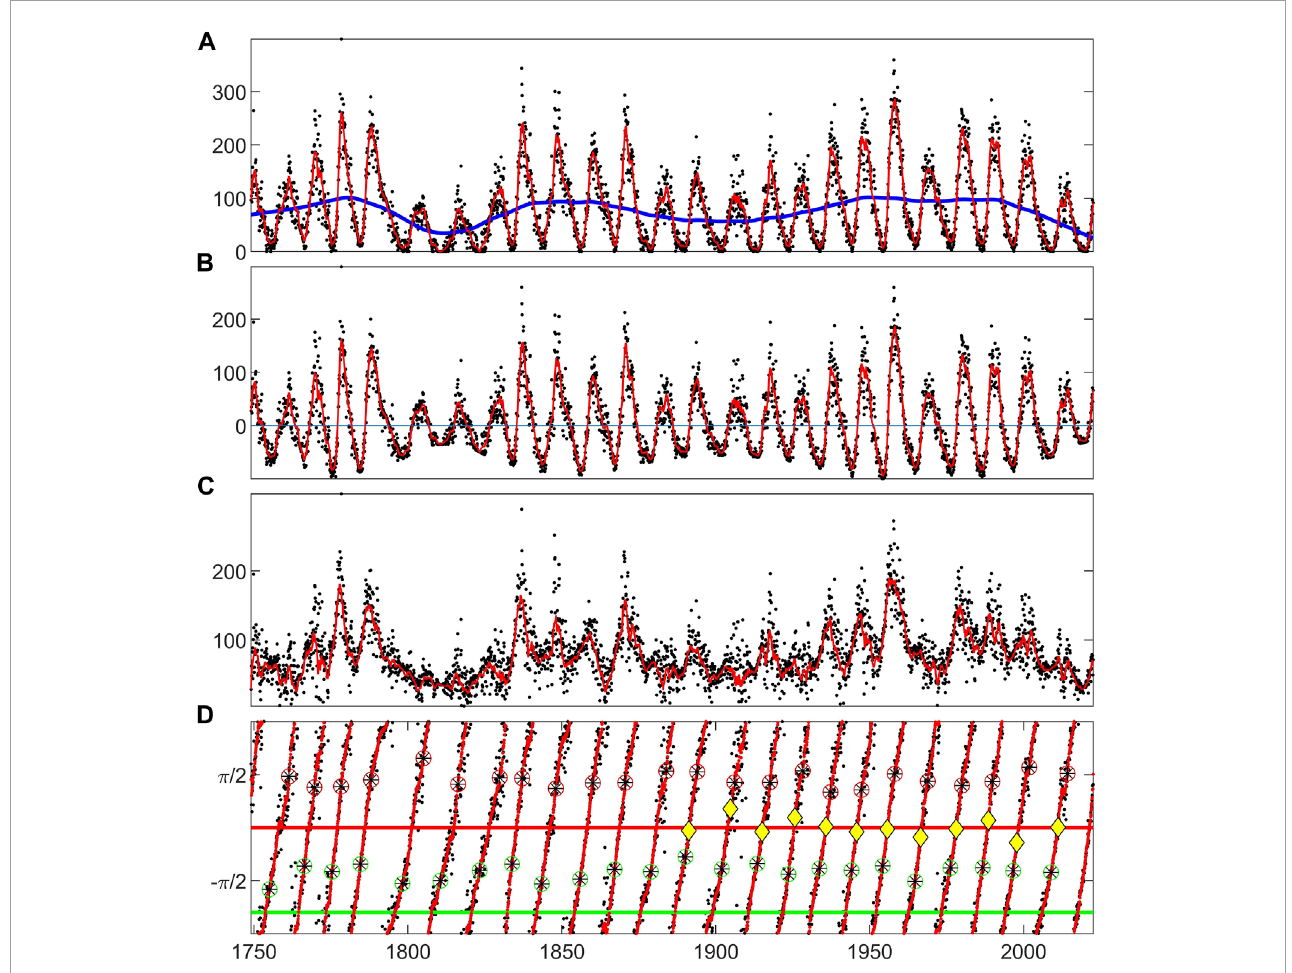
FIGURE 1 Analytic signal of the monthly sunspot record time-series. Monthly sunspot number (black dots) and its 13 month running mean (red) are plotted: (A) with the slow trend (blue), the 40 year window local linear regression of monthly sunspot number. (B) with the slow trend subtracted. This is Hilbert transformed to obtain the analytic signal with amplitude (C) and phase (D) . In (D) , solar maxima and minima are indicated by the red and green circled asterisks respectively, terminators by yellow diamonds. Zero phase is set at the average of the terminator times from McIntosh et al. (2019). Horizontal lines are at phases zero (terminator, red) and − 4 π / 5 (pre-terminator,